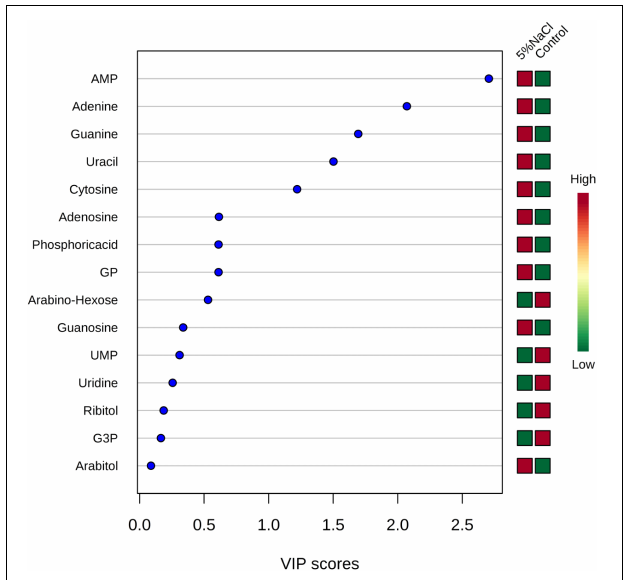
FIGURE 7 | Variable importance in projection (VIP) scores for the top metabolites contributing to variation in metabolic profiles of controls vs. cold treatment samples. The relative abundance of metabolites is indicated by a colored scale from green to red representing the low and high,